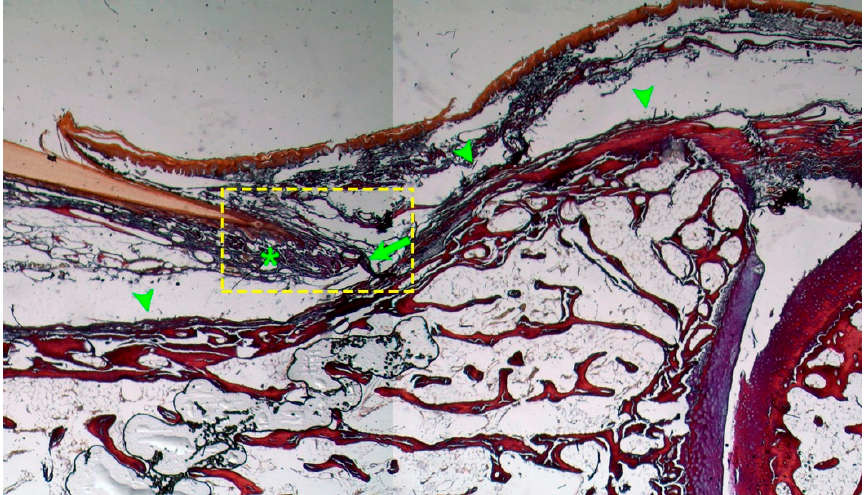
Figure 6. High-power magnification of the green squared area of Figure 4. Deep fibers of the extensor pollicis longus tendon (EPLT) bundles run along the dorsal aspect of the distal phalanx of the thumb (arrowheads). Superficial fibers of the EPL (arrow) are attached at the base of the ventral nail matrix (asterisk) and to the underlying bone crossing the superficial fibers of the EPLT bundles (10× magnification). Tetrachrome VOF-III GS stain (light green SF/or fast green FCF, methyl blue, Orange G, and acid fuchsin).